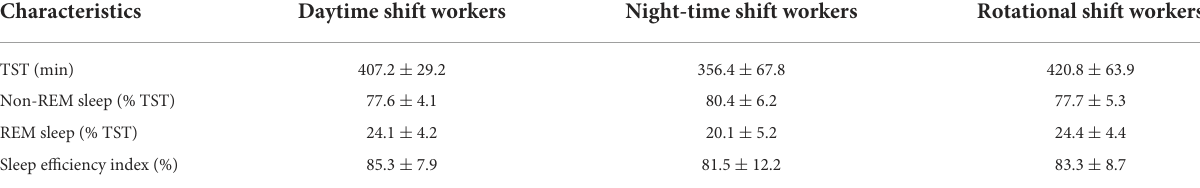
TABLE 5 Sleep study data of various shift